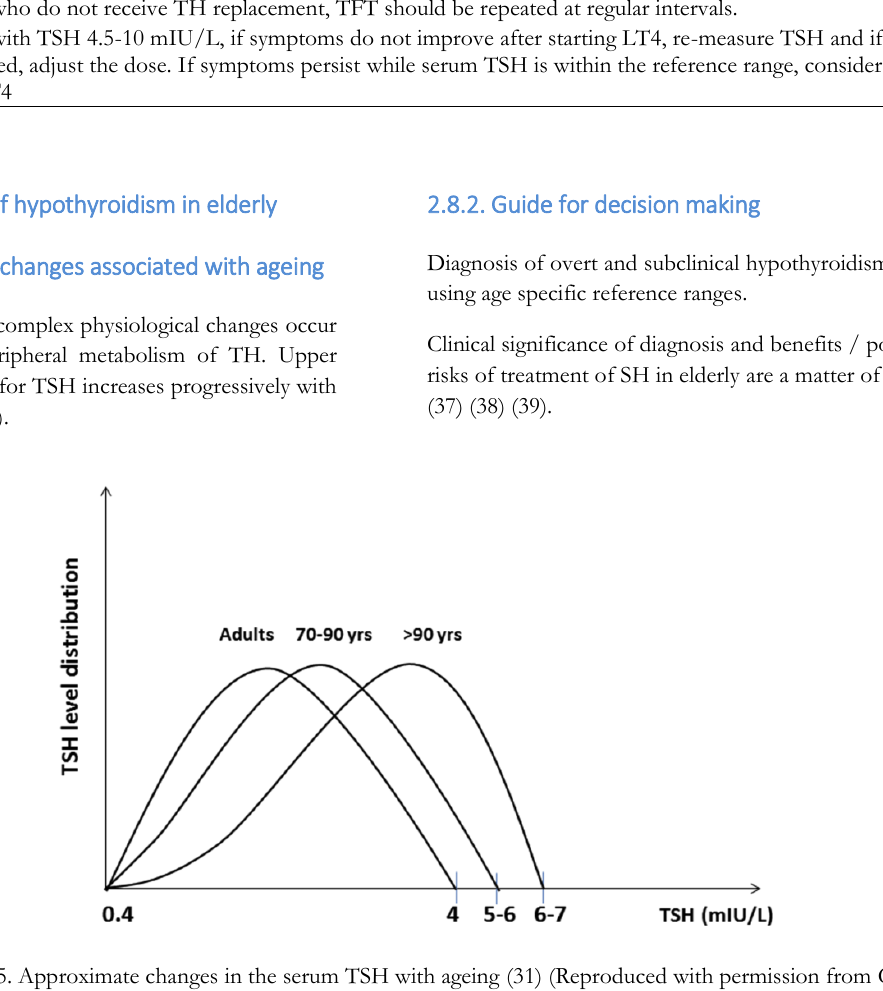
Figure 2.5. Approximate changes in the serum TSH with ageing (31) (Reproduced with permission from Calsolaro V et al. Hypothyroidism in the Elderly: Who Should Be Treated and How? J Endocr Soc.